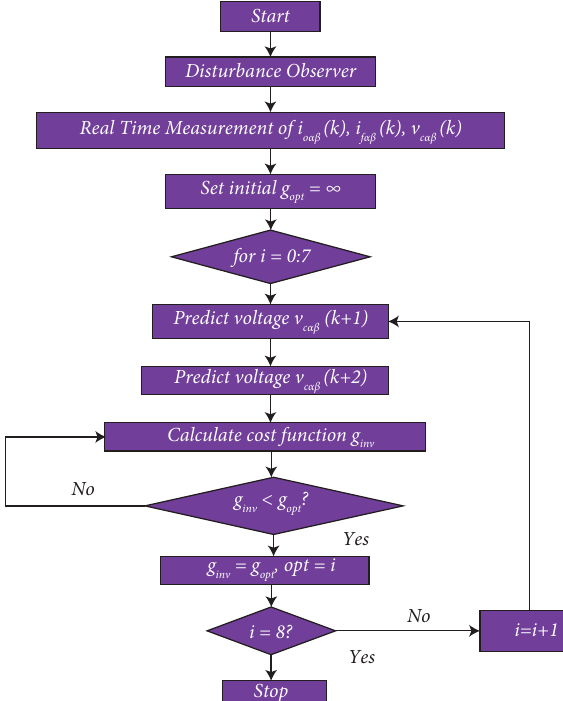
Figure 9: Te fowchart of the implemented FCS-MPC